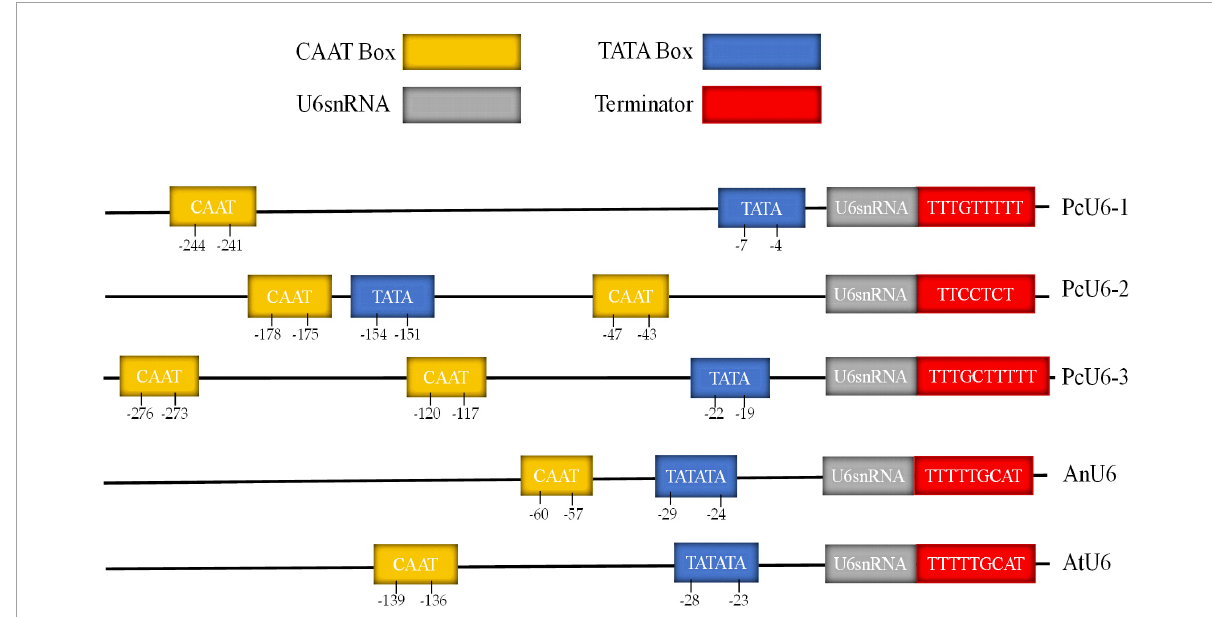
FIGURE1 The comparative analysis of promoter and terminator of U6 snRNA genes of the species Poria cocos , Aspergillus nidulans, and Arabidopsis thaliana .